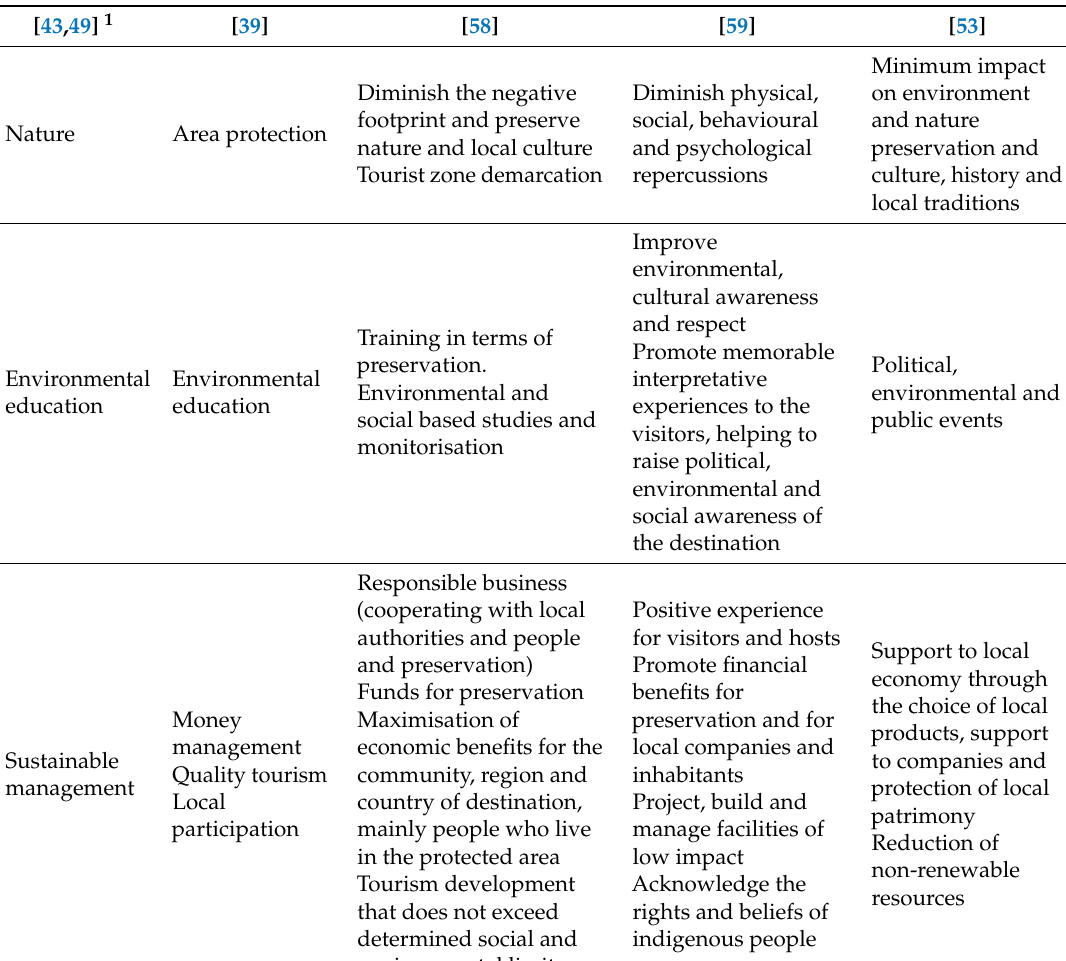
Table 1. The Pillars of